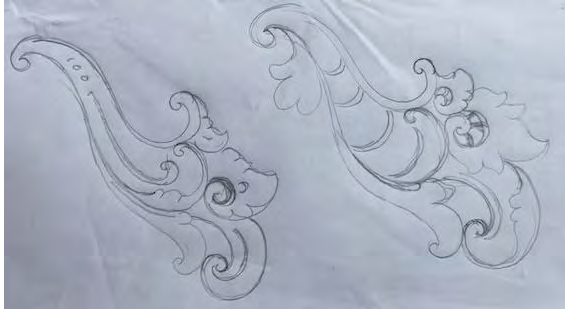
Figure 9. An artist’s sketch of a native Patra Punggel carving (left) and with the French influence